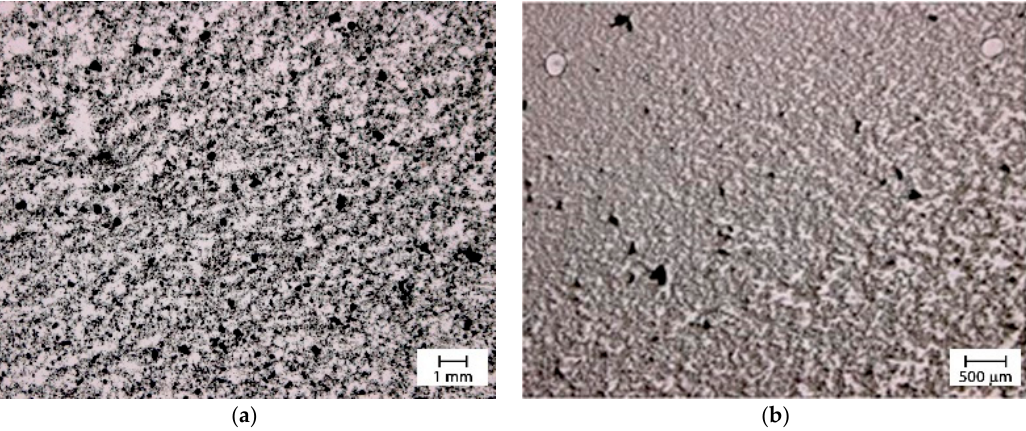
Figure 11. Optical micrographs of the dispersion obtained applying gear speed at 60 rpm for 60 min, ( a ) two gear head ( b ) three gear head.